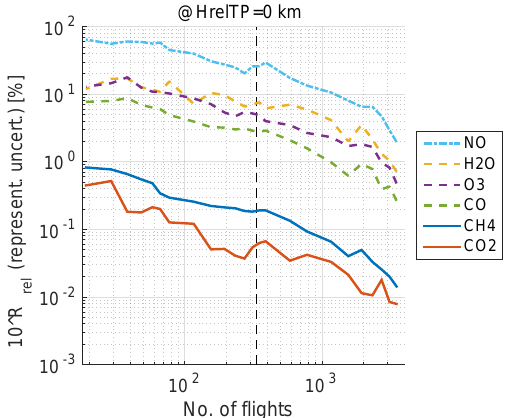
Figure 11. Representativeness uncertainty for different numbers of flights for some species. The number of flights in MEAS CARIBIC is indicated by the vertical dashed line. Other species can be deduced from their value of τ ∗ with the help of Fig.